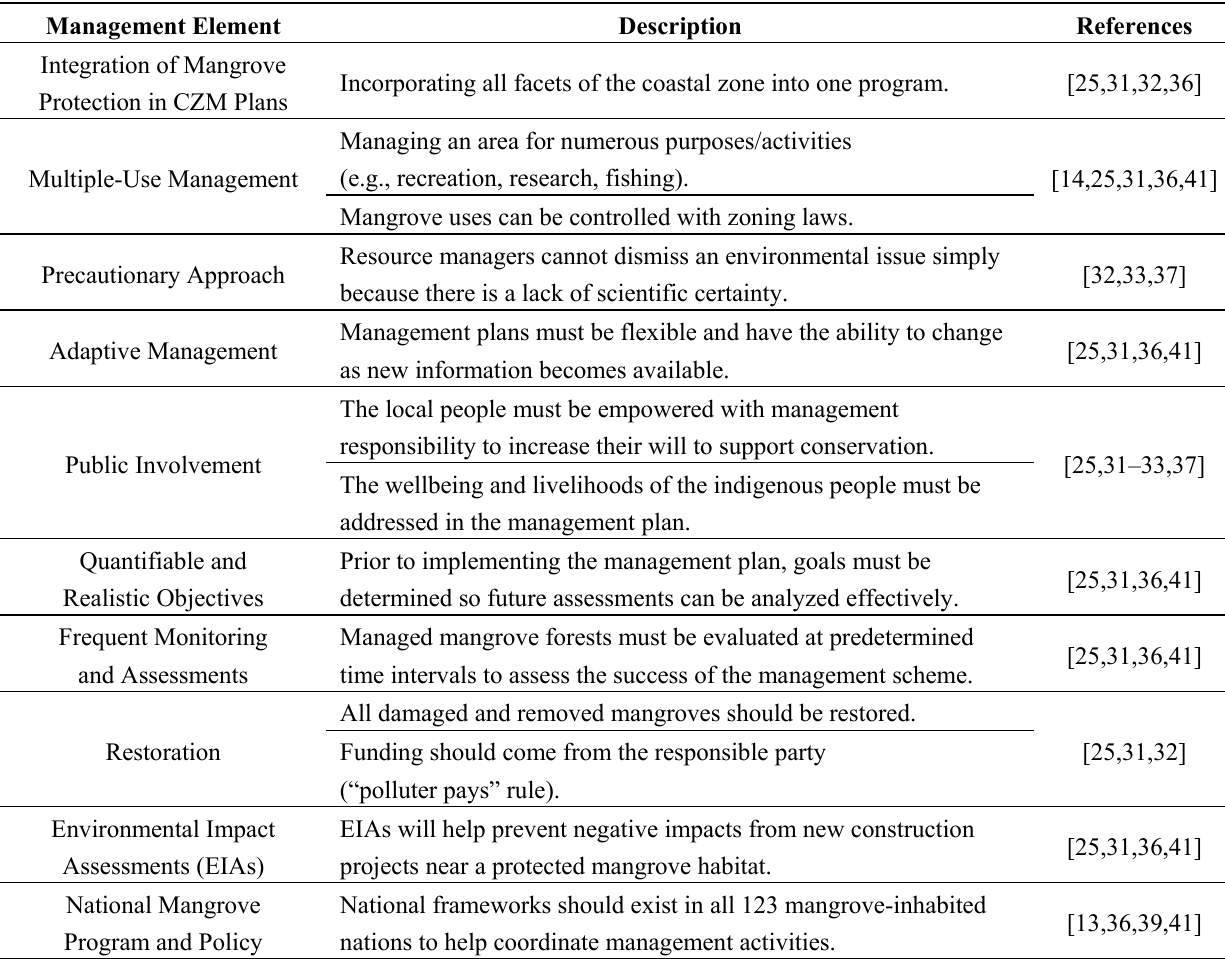
Table 3. Key elements of mangrove management as presented by the FAO Forestry Department, ITTO, Ramsar Convention, and the ISME in the corresponding management guideline